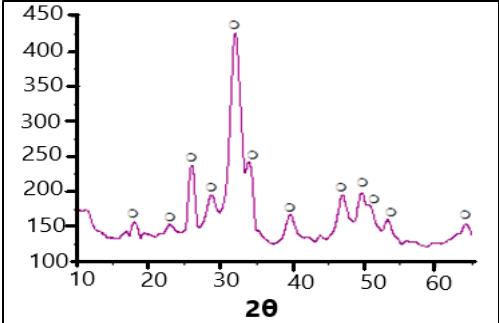
Figure 1. XRD spectrum of HAp obtained from the